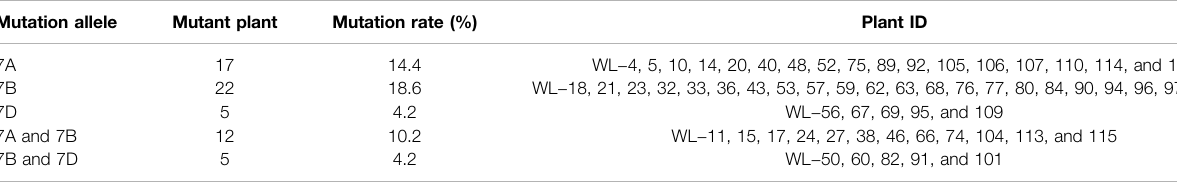
Lower case letters represent mutant types; capital letters represent wild type.